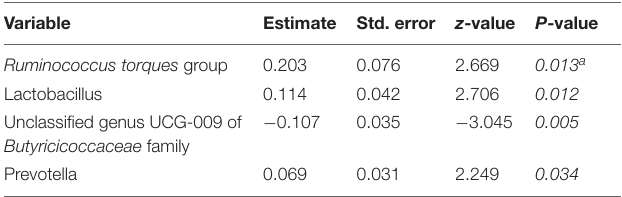
TABLE 8 | Reduction in diarrhea symptom severity linear model: demographics + genomics + microbiome (D + G +